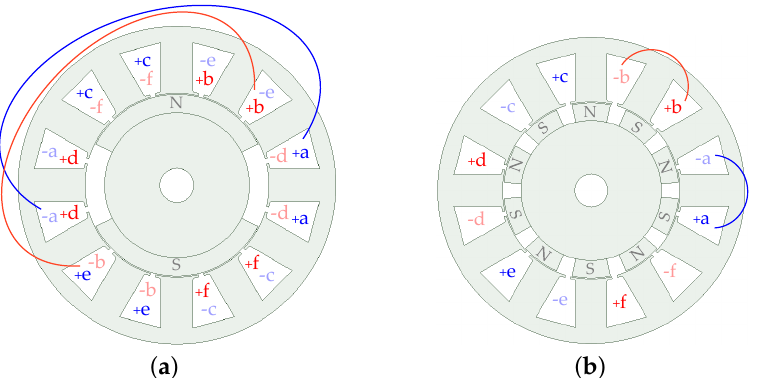
Figure 5. Difference between overlapping and non-overlapping windings, for a six-phase machine with symmetrical WSA. ( a ) Overlapping. ( b ) Non-overlapping (namely, FSCW). Among non-overlapping windings, fractional-slot concentrated windings